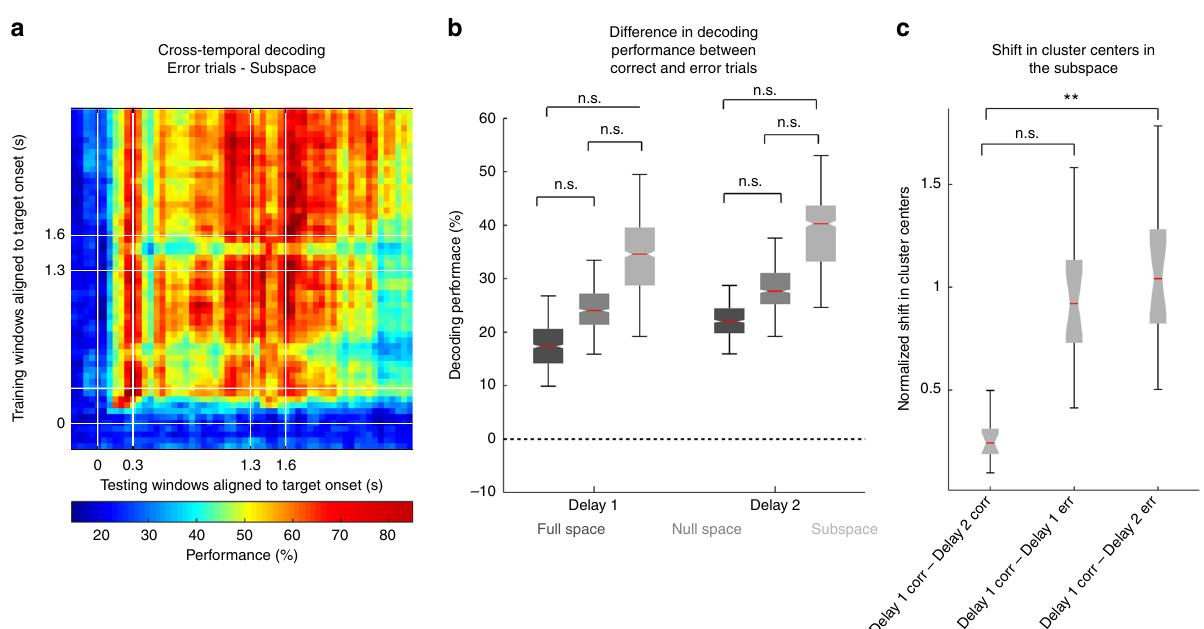
Fig. 4 Subspace decoding in error trials. a Heat map showing the cross-temporal population-decoding performance in the subspace for error trials (only four target locations with high error rates are included). b The differences in decoding performance between correct and error trials are shown in the full space (black box-plot), subspace (gray box-plot), and the null space (dark gray box-plot) for both Delays 1 and 2. c The normalized shift in cluster centers in the subspace is shown for correct trials between Delay 1 to Delay 2 (black box-plot), between correct and error trials in Delay 1 (dark gray box-plot), and between correct trials in Delay 1 and error trials in Delay 2 (gray box-plot). The bounds in the boxplots are de fi ned by the 25th and 75th percentile of the distribution. The red line represents the median and the whiskers represent the 2.5th and 97.5th percentile of the